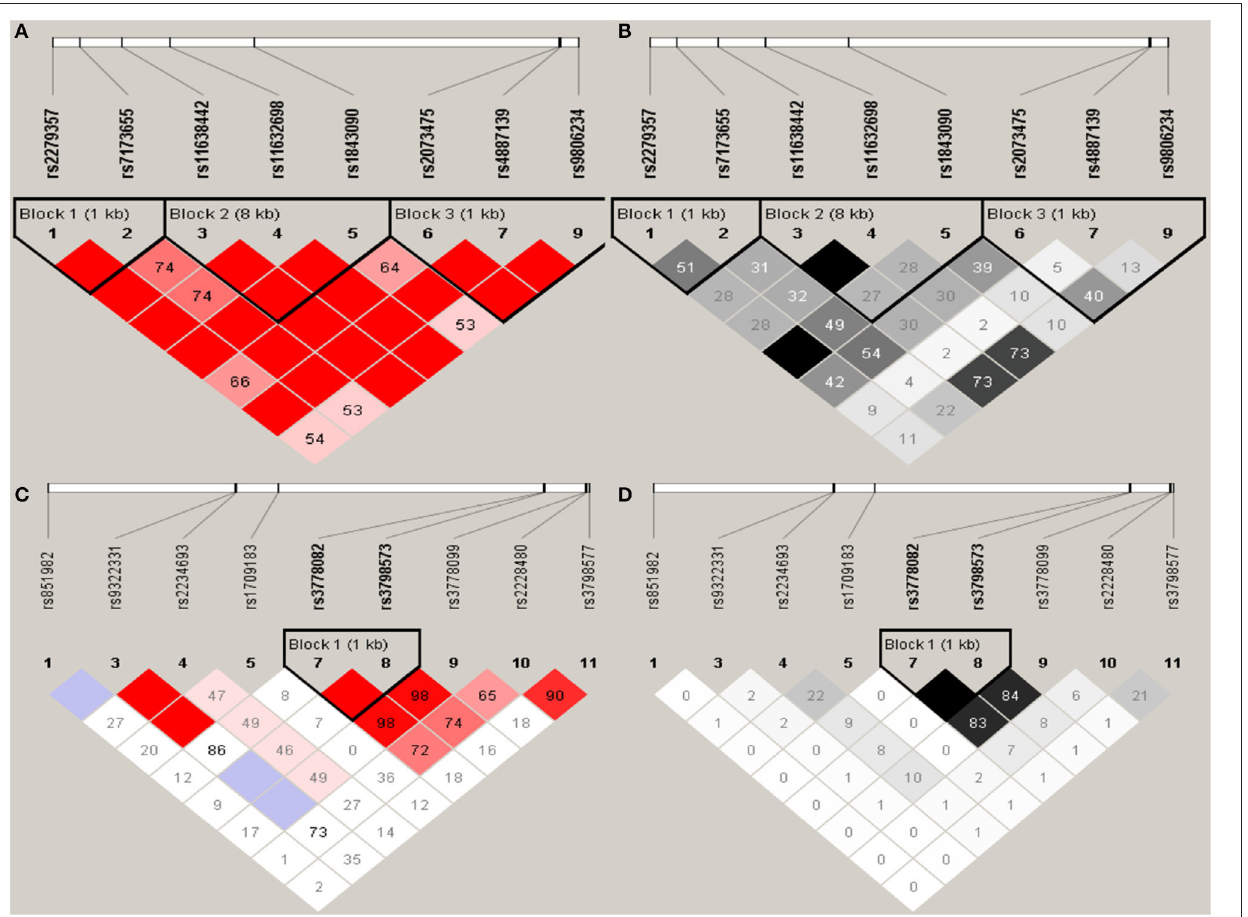
FIGURE 1 | Graphical representations of the SNP locations and LD structure of CYP11A (A,B) and ESR1 (C,D) using tested genotyped SNPs in 331 controls.